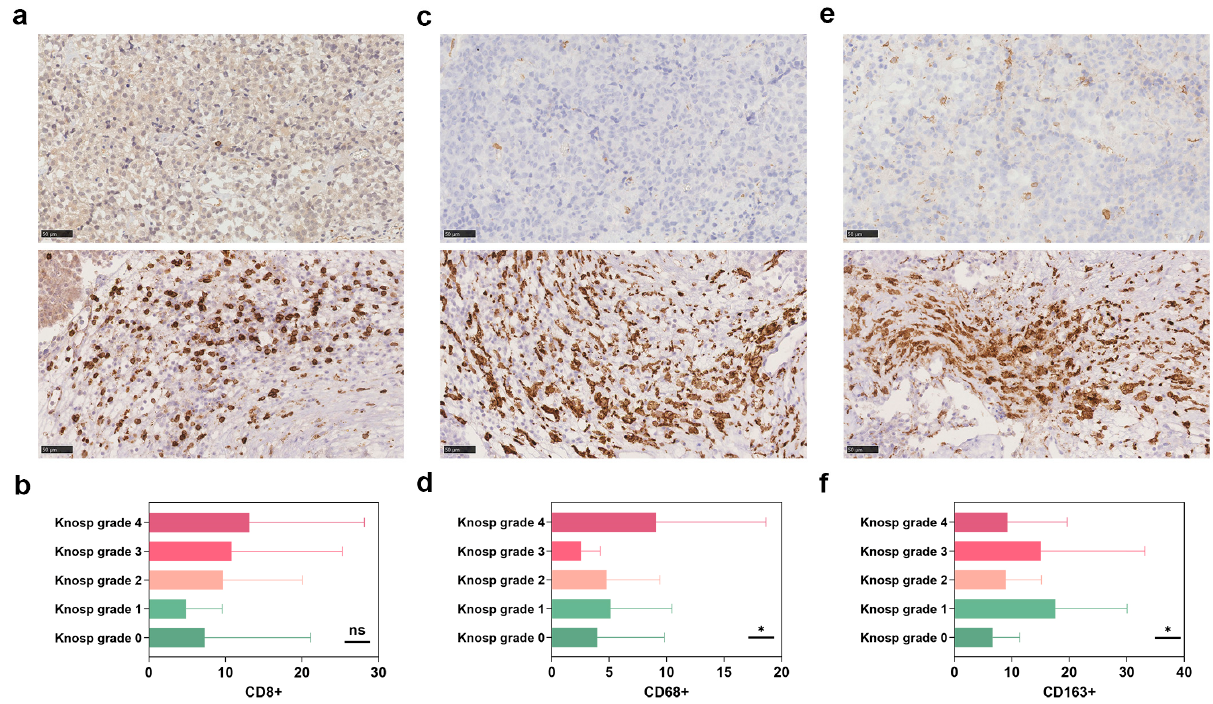
Figure 1. Immunohistochemistry of tissue microarray for immune cells in pituitary adenoma (PA). The different distribution of CD8+ TILs between the non- aggressive PA and aggressive PA at ×400 magnification ( a ) and the Knosp grades ( b ); the different distribution of CD68+ macrophages sur- rounding the vessels between the non-aggressive PA and aggressive PA at ×400 magnification ( c ) and the Knosp grades ( d ); the different distribution of the density of infiltrating CD163+ macrophages be- tween the non- aggressive PA and aggressive PA at ×400 magnification ( e ) and the Knosp grades ( f ). The final scores of MMP-9 staining were positively related to Knosp grade (r = 0.22, p = 0.03) (Figure 2); however, statistical significance was not found in the expression of MMP-9 between the Knosp grades ( p = 0.127; Figure 3e,f). In addition, they were not related to the Ki-67 index ( p = 0.76) and tumor volumes ( p = 0.33). Interestingly, the final scores of MMP-9 immunoreactivity were positively correlated with the number of CD8+ TILs (r = 0.26, p = 0.01) and CD68+ macrophages (r = 0.32, p = 0.00) beyond CD163+ macrophages ( p = 0.38). The numbers of CD163+ macrophages infiltrating PAs were highly variable with statistically significant differences among the MMP-9 scores ( p = 0.04)